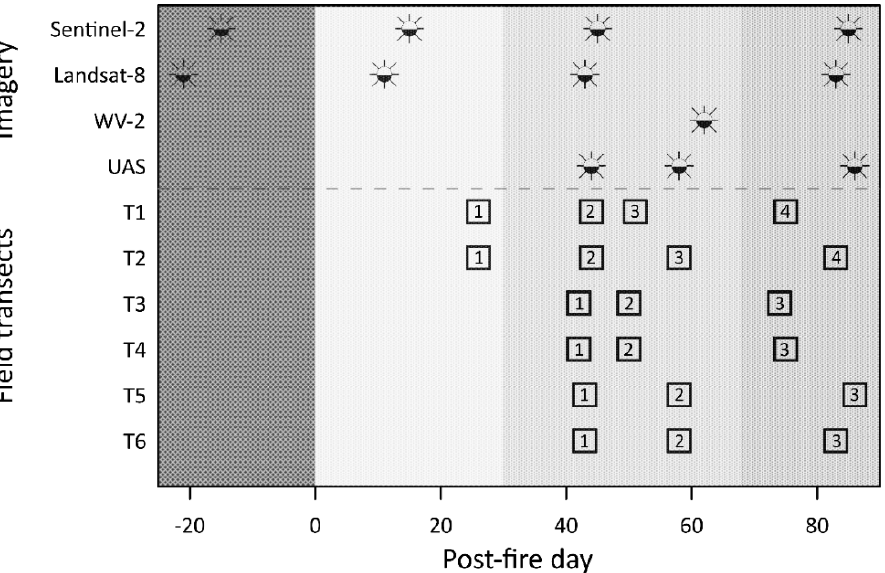
Figure 3. Timeline showing the correspondence between the image acquisitions and the Mesa Fire field data collection. Abbreviated imagery types: WorldView-2 (WV-2) and Unmanned Aircraft System (UAS). The number inside the square indicates the field visit number. Only the satellite imagery was used analytically, while the UAS imagery was used obser- vationally.